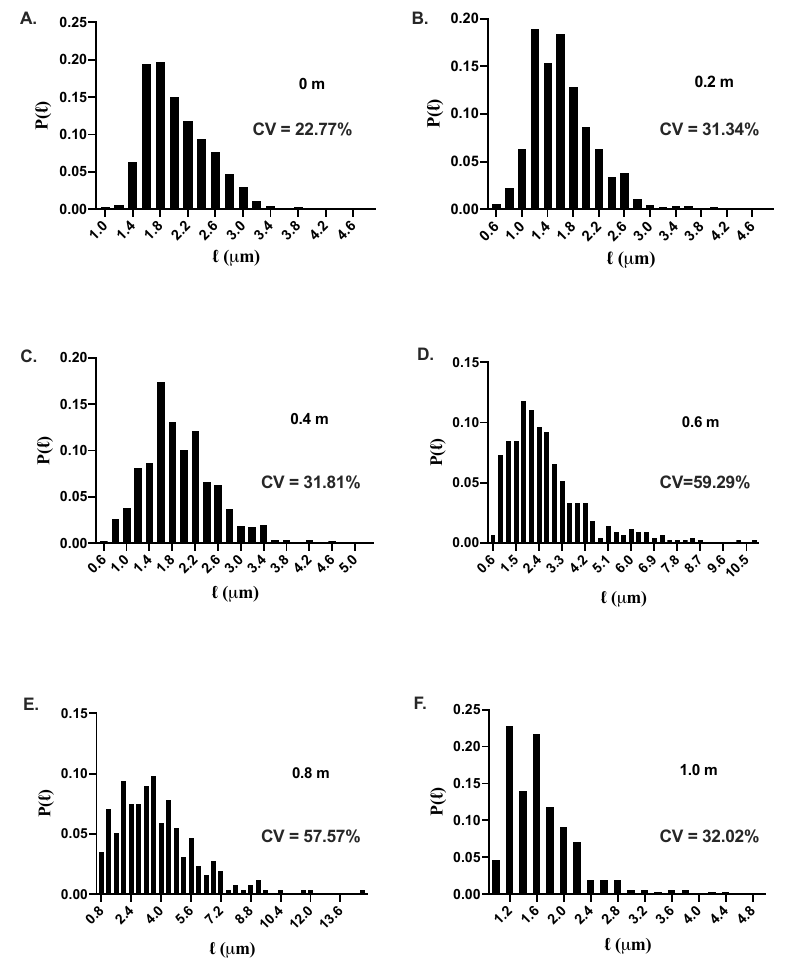
Figure 5. Probability distribution function, P ( (cid:96) ) , of cell length, (cid:96) , for Na 2 SO 4 concentrations: ( A ) 0 m, ( B ) 0.2 m, ( C ) 0.4 m, ( D ) 0.6 m, ( E ) 0.8 m, and ( F ) 1.0 m. The cell length distribution exhibits large heterogeneities at high concentrations of sodium sulfate. For 1.0 m Na 2 SO 4 , the bacterial cells do not exhibit any growth, and the cell length becomes smaller, presumably due to water efflux. Coefficient of variation (CV) of the probability distributions for all the salt concentrations are also